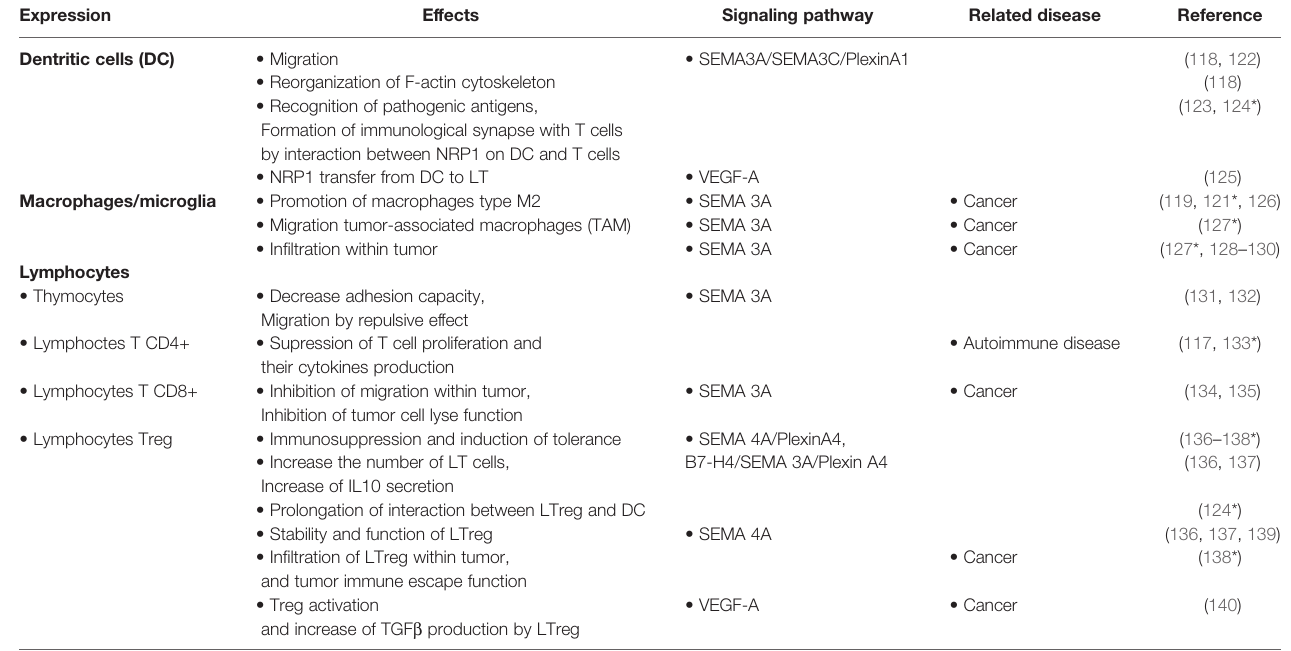
TABLE 1 | Summary NRP1 involvement in the immune system.